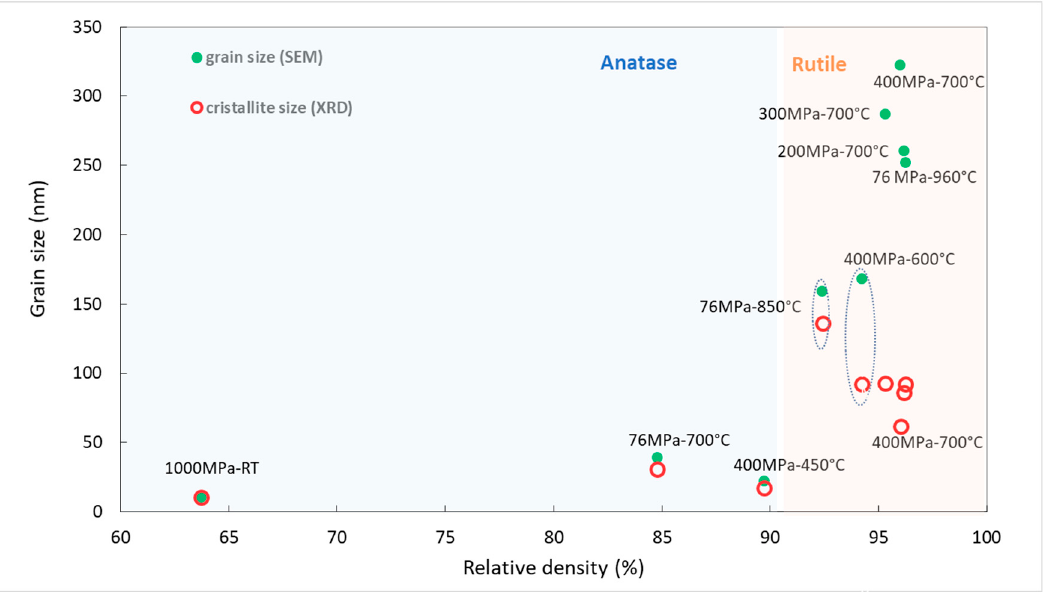
Figure 11. Grain size and crystallite size versus relative density for all samples.